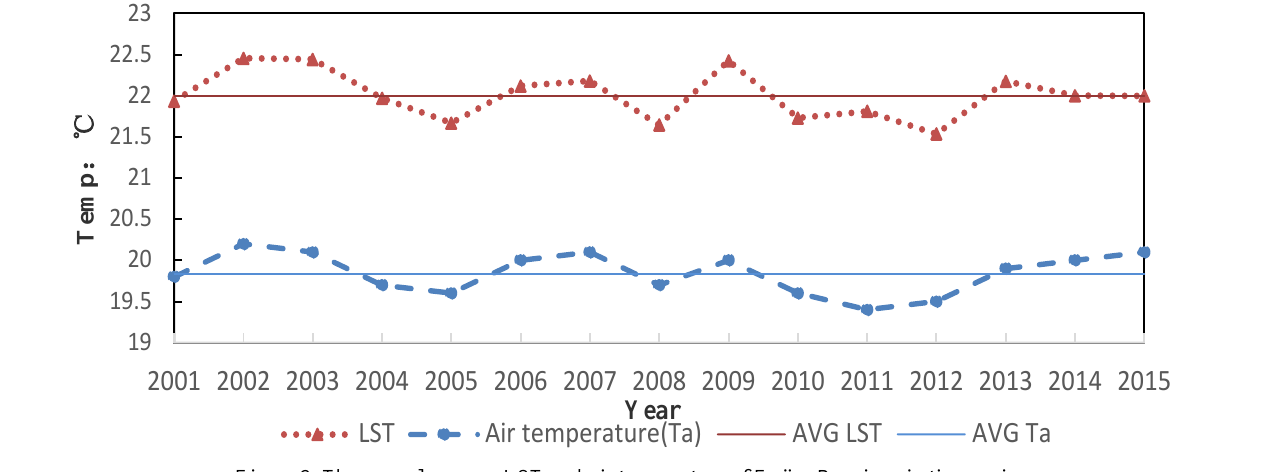
Figure 2. The annual average LST and air temperature of Fujian Province in time series